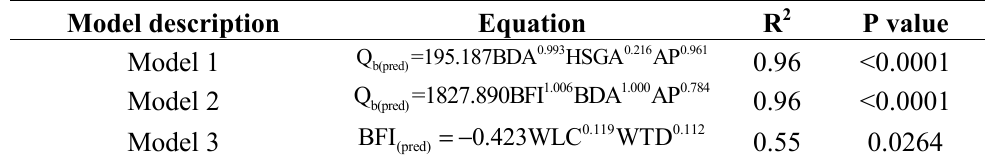
Table 6. Regression equations for estimating annual baseflow and baseflow index in